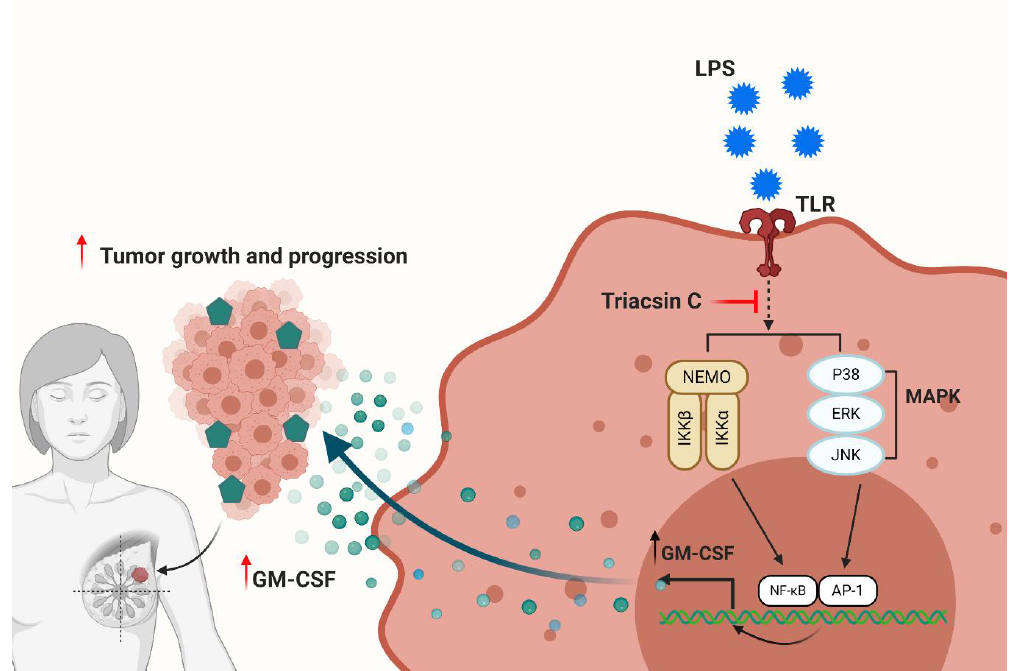
Figure 5. A novel role of ACSL1 in LPS induced GM-CSF production in MDA-MB-231 breast cancer cells. LPS: Lipopolysaccharide; ACSL1: long-chain acyl-CoA synthetase 1; p38 MAPK: p38 mitogen- activated protein kinase ERK: extracellular signal-regulated kinase; NF-κB: nuclear factor kappa- light-chain-enhancer of activated B cells; GM-CSF: granulocyte-macrophage colony-stimulating factor.